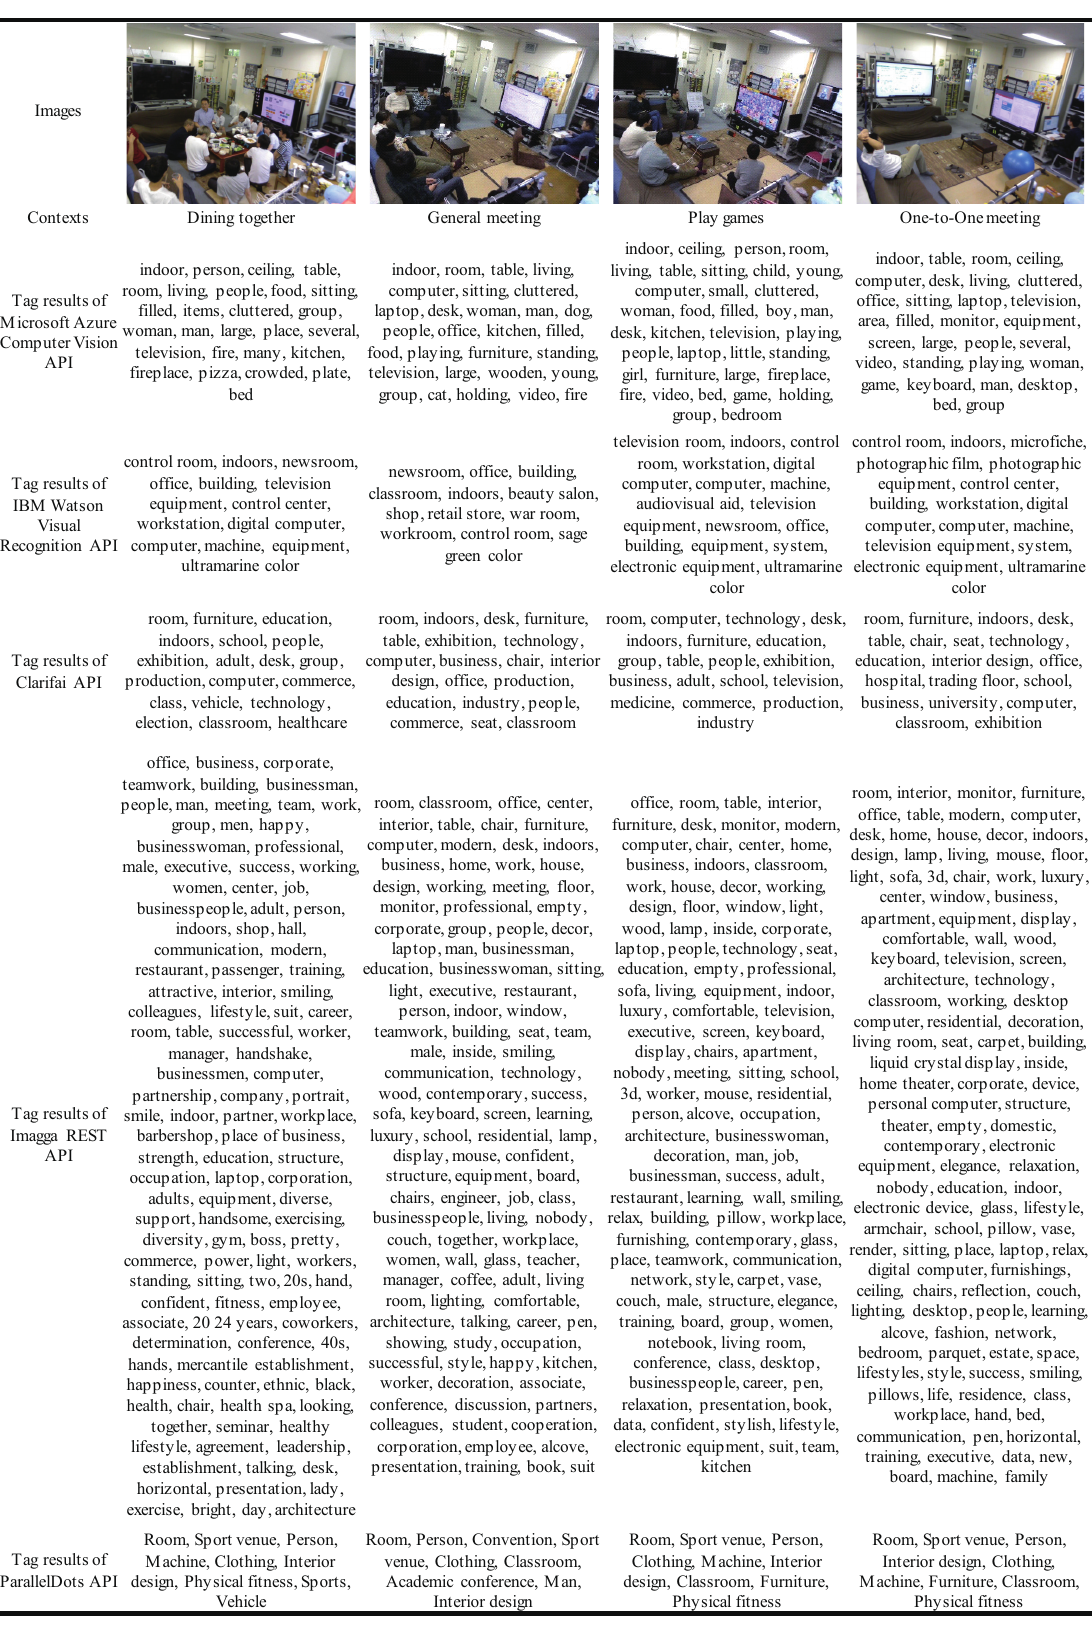
Table 2. The representative images of the four contexts (including tag results from different